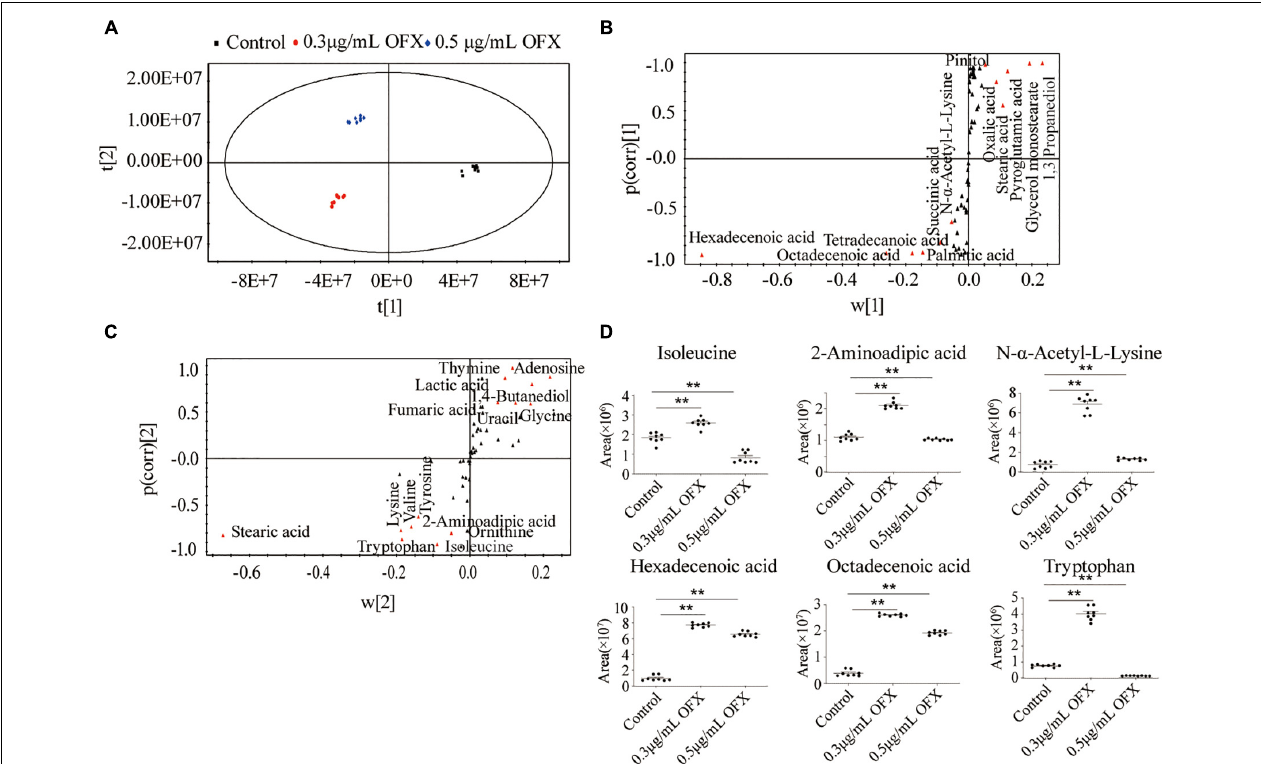
FIGURE 6 | Identification of crucial metabolites using multivariate data analysis. (A) Principal-component analysis of control, 0.3 µ g/ml OFX, and 0.5 µ g/ml OFX groups according to the treatment set. Each dot represents the technological replicate analysis of samples in the plot. (B) S-plot generates from OPLS-DA. Predictive component p [1] and correlation p (corr)[1] differentiate control from 0.3 and 0.5 µ g/ml OFX. (C) S-plot generates from OPLS-DA. Predictive component p [2] and correlation p (corr)[2] separate 0.3 µ g/ml OFX from 0.5 µ g/ml OFX. Triangles represent metabolites. Potential biomarkers are highlighted in red. (D) Abundance of crucial metabolites in control and 0.3 and 0.5 µ g/ml OFX. Statistical analysis was performed with Mann–Whitney U -test. ** P <